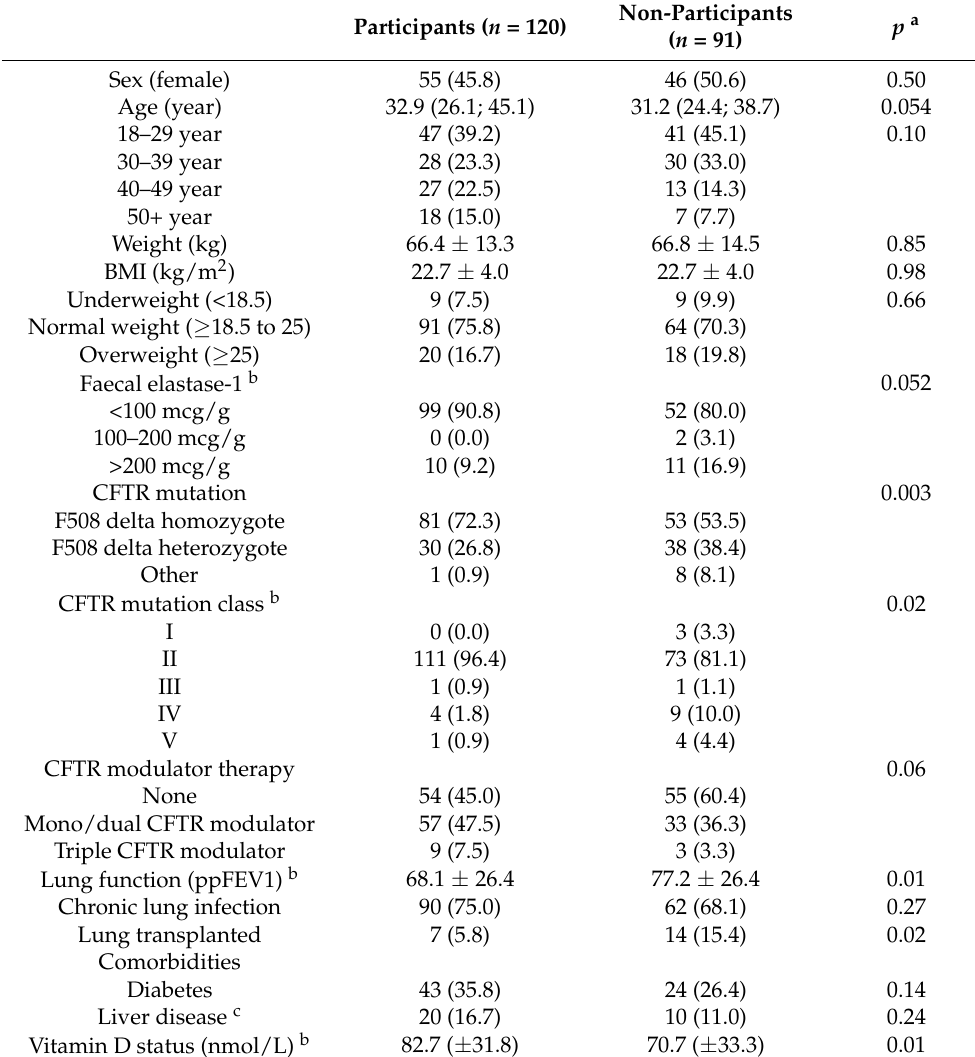
Table 1. Characteristics of participants and non-participants among adults with cystic